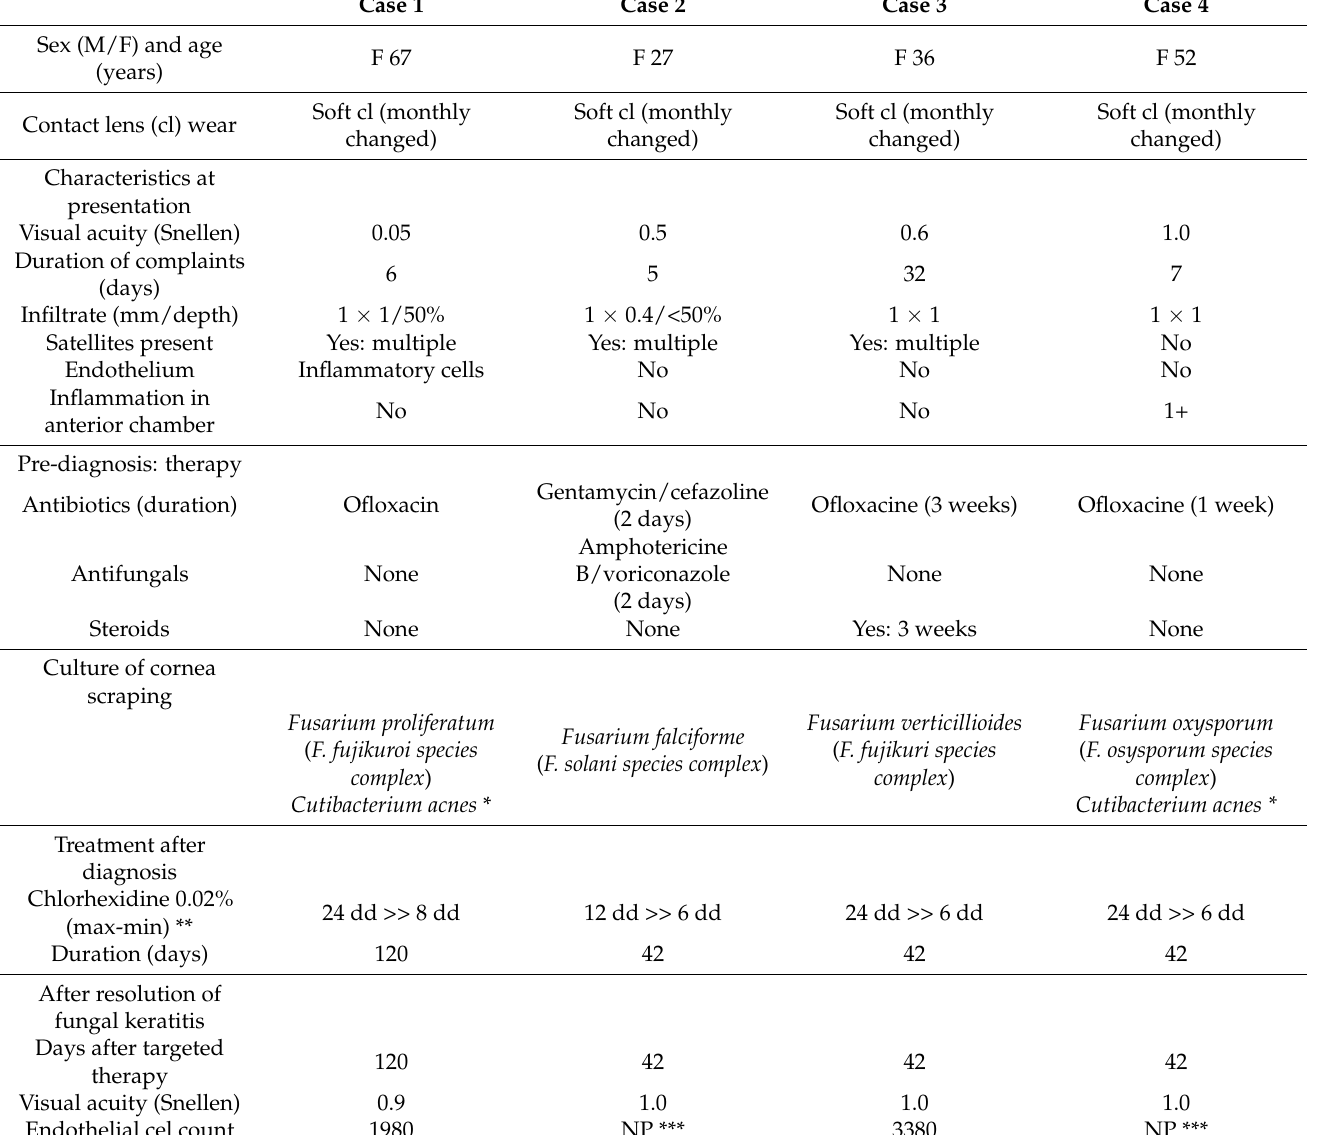
Table 1. Demographic characteristics and outcome of fungal keratitis patients treated with chlorhexidine